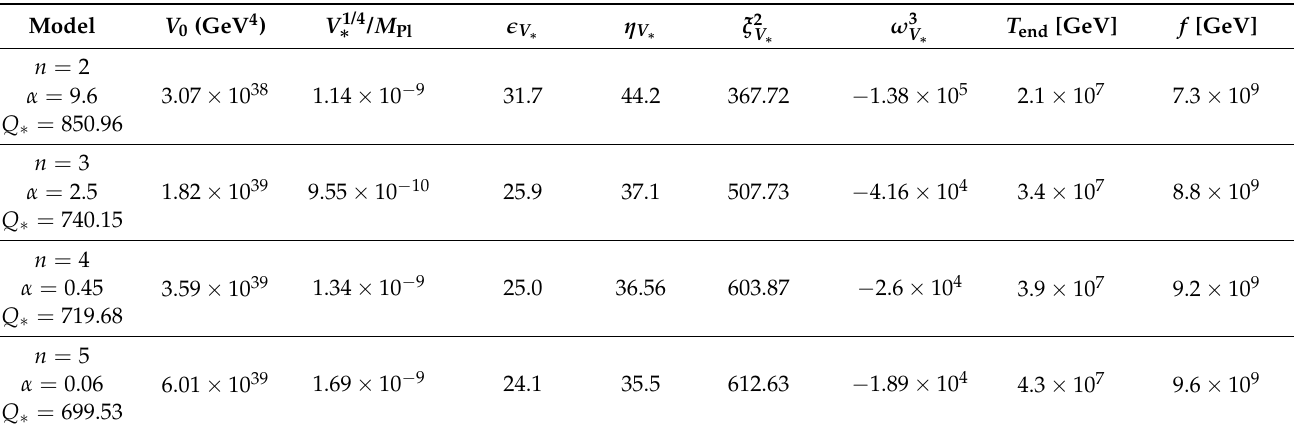
Table 3. Values for the parameters considered in the analytical estimation of n s , α s and β s for 4 sets of the chosen model parameters. The number of e-folds N ∗ is obtained from Equation (54), and it is N ∗ (cid:39) 48 for all the cases shown here